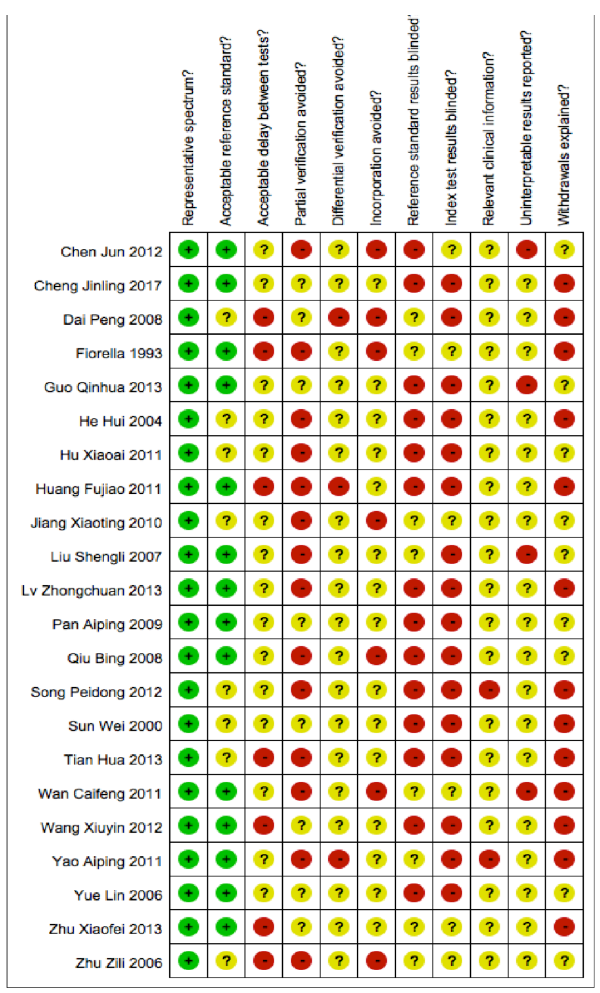
Figure 2: The methodological quality summary for each included study. (The authors’judgments for each risk of bias item. + is “low risk”; - is “high risk’’; ?is“moderate